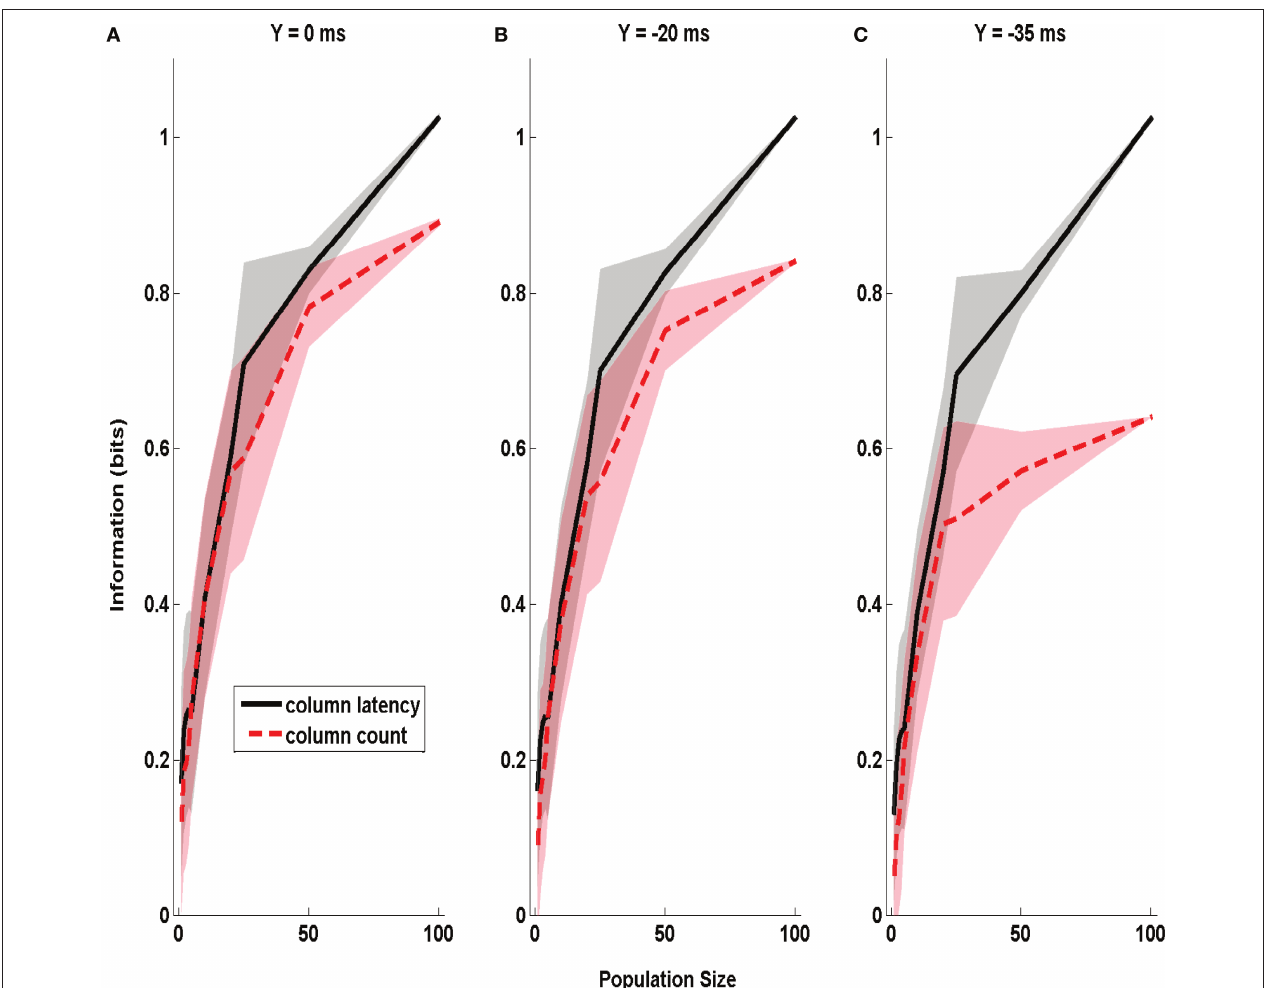
onset, and is plotted as a function of the size of the population of D2 neurons considered. (A–C) Report information values which were obtained when using respectively the values 0, − 20, and − 35 ms for the parameter Y quantifying the uncertainty about the stimulus time. Results are plotted as average ( ± SD; colored area) across all analyzed subgroups of cells with the specified population